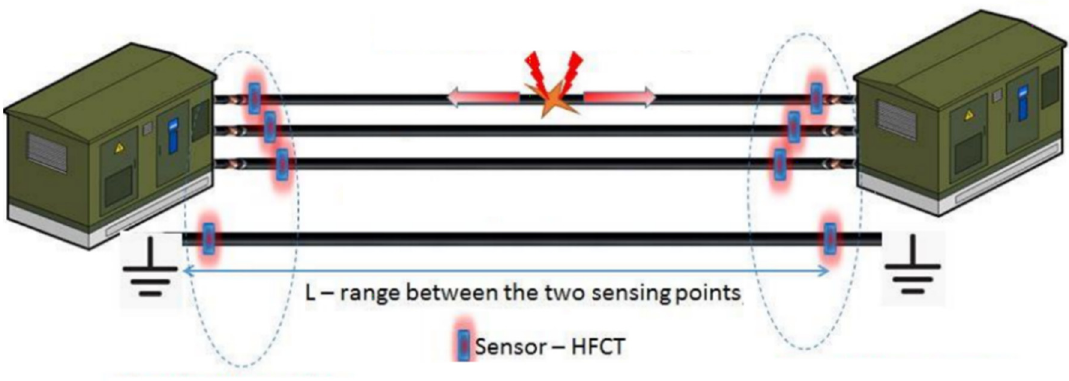
Figure 5. The experimental benchmark.